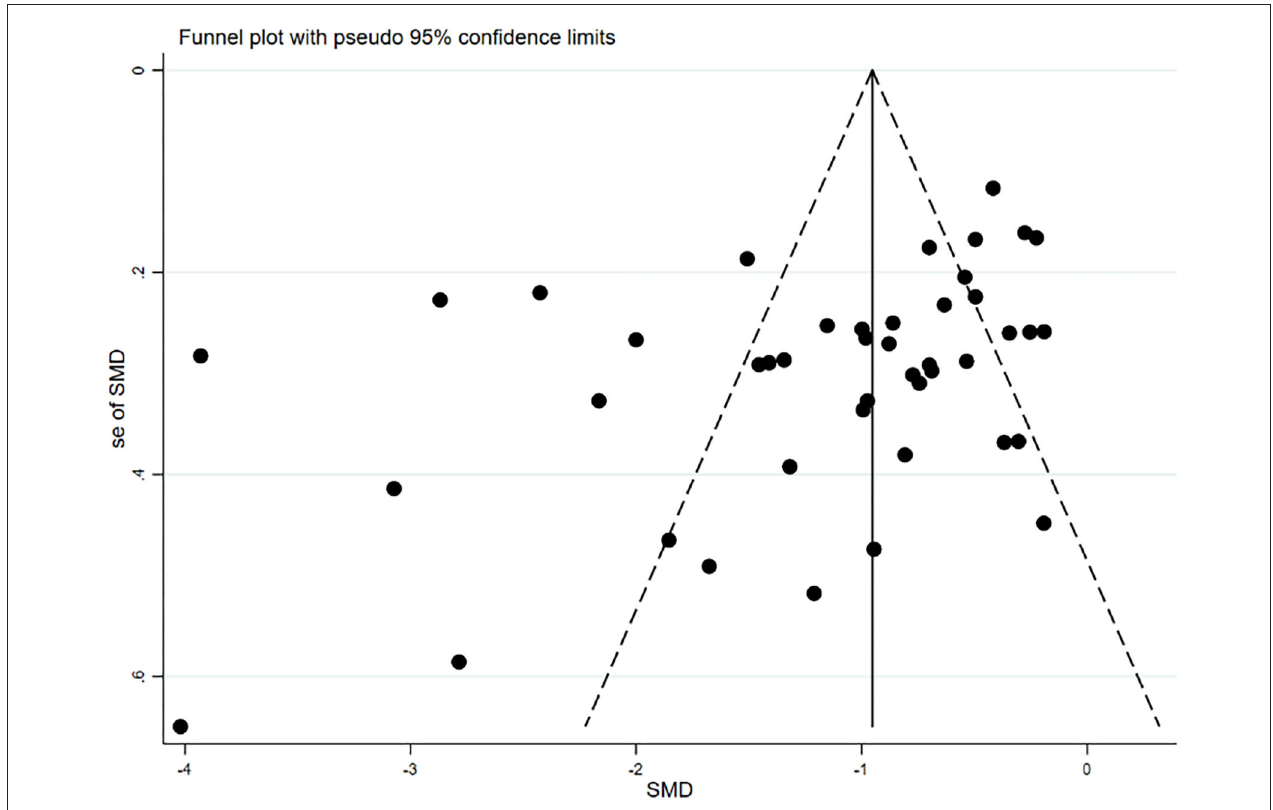
FIGURE 3 | Funnel plot of interventions of learning